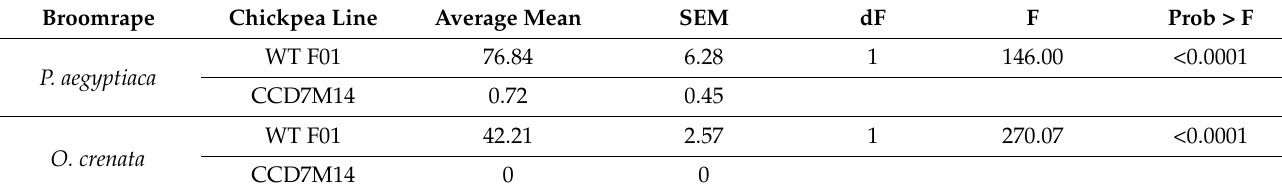
Table 2. Statistical analysis of the broomrape seed germination closed to chickpea roots. The results were subjected to ANOVA. The experiments were conducted with five replications. SEM—standard error of the mean, dF—Degrees of Freedom; F—F ratio, Prob > F—F probability.